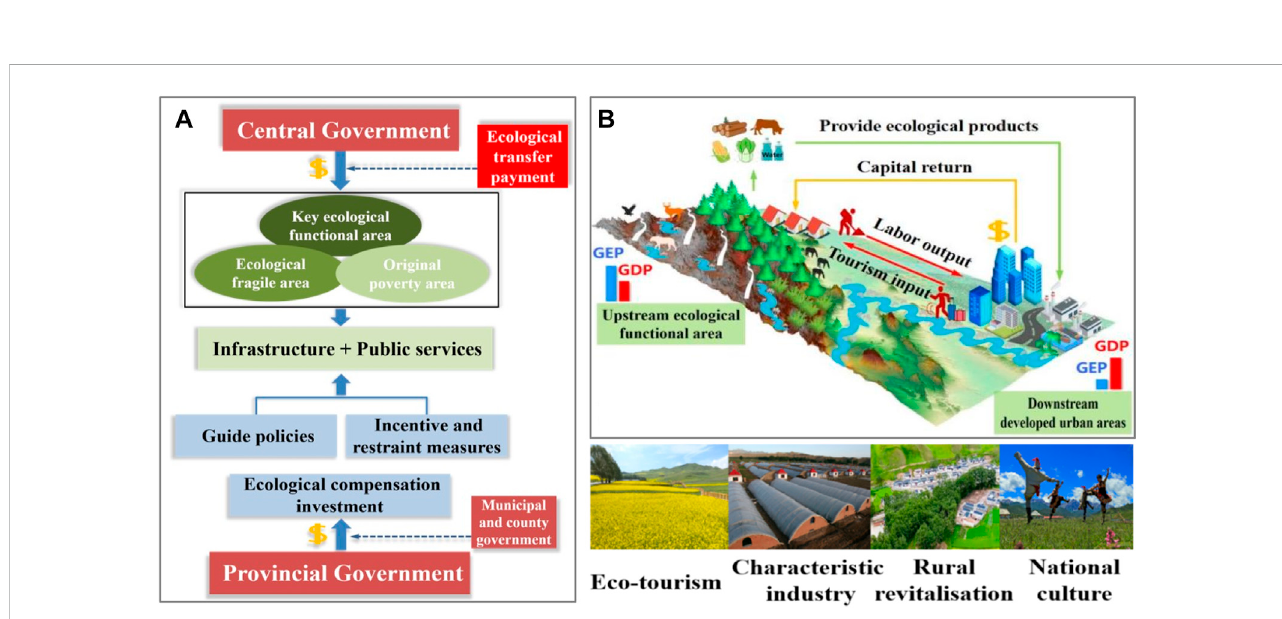
FIGURE 8 Path model of ecological protection compensation mechanism with Chinese characteristics. Note: A represents the vertical ecological protection compensation path model, i.e. the central government increases the scale of ecological transfer payments to ecological function areas, while local governments increase the investment of ecological protection compensation funds and formulate guiding policies and incentive and restraint measures for ecological protection compensation.This model is mostly based on direct fi nancial compensation. B represents the cross regional horizontal ecological protection compensation mechanism path model. The ecological function area exports ecological products (fresh water, food, etc.) and labor force to developed areas, so as to obtain capital return and fi nally realize the coordinated development of various regions. The photo comes from the of fi cial website of Tianzhu County, China (http://www. Gstian zhu.gov.cn/accessed 29 October